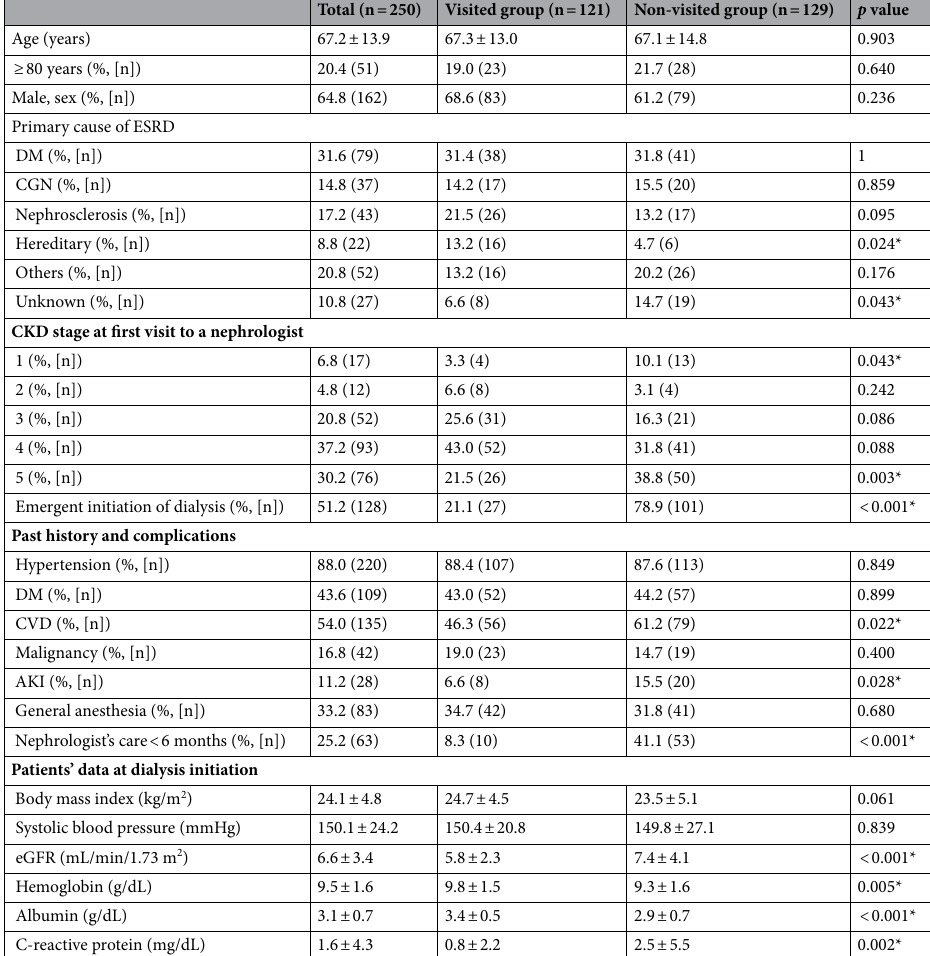
Table 1. Baseline characteristics of the participants. Data are presented as mean ± standard deviation (range) unless otherwise stated. ESRD, end-stage renal disease; DM, diabetes mellitus; CGN, chronic glomerular nephropathy; CKD, chronic kidney disease; CVD, cardiovascular disease; AKI, acute kidney injury; eGFR, glomerular filtration rate. * p < 0.05.